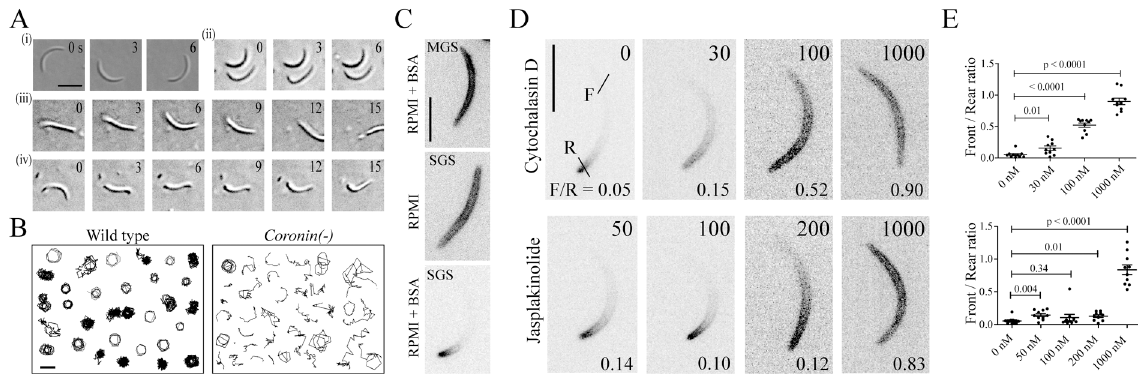
Fig 1. Coronin is important for directional motility and localizes to the rear in an actin-dependent manner. (A) Wild type (WT) P . berghei strain ANKA parasites (i) and coronin(-) (ii-iv) sporozoites were allowed to settle on a glass-bottom Petri-dish and imaged with differential interference contrast microscopy. WT sporozoites move in near-perfect circles with an average speed of about 2 μ m/s, while coronin(-) sporozoites frequently fail to move or undergo different types of non-persistent movements such as sporadic translocation [37] or various types of flexing behavior (iii-iv). Scale bar: 10 μ m. (B) Sporozoites as imaged in A were tracked using ImageJ. Tracks of randomly selected WT sporozoites reveal the persistent circular movement while tracks of coronin (-) sporozoites reveal non-circular trajectories. Scale bar: 10 μ m. (C) Parasites expressing coronin-mCherry were generated (see S4A Fig) and sporozoites imaged in RPMI medium with a fluorescence microscope in the presence and absence of the motility stimulating bovine serum albumin (BSA). Non-motile sporozoites isolated from the mosquito midgut (MGS) or salivary gland (SGS) showed peripheral fluorescence. Motile salivary gland derived sporozoites showed a fluorescent signal at the rear end. Note the high background in the non-motile sporozoite images indicating the low expression level of coronin-mCherry. There is no quantitative difference in expression level of activated and non-activated sporozoites. Scale bar: 5 μ m. (D) Motile sporozoites expressing coronin-mCherry were imaged with a fluorescence microscope under various concentrations of the actin dynamics modulating compounds cytochalasin D and jasplakinolide as indicated at the top right of each panel (in nM). Note the relocalization of the fluorescence signal with increasing drug concentrations. Bars in the top left panel indicate lines where fluorescent intensity profiles were taken to determine front versus rear (F/R) intensity ratios of coronin-mCherry. A low F/R ratio indicates localization to the rear end. Scale bar: 5 μ m. (E) Quantitative assessment of the F/R ratio from at least 10 images taken under the indicated